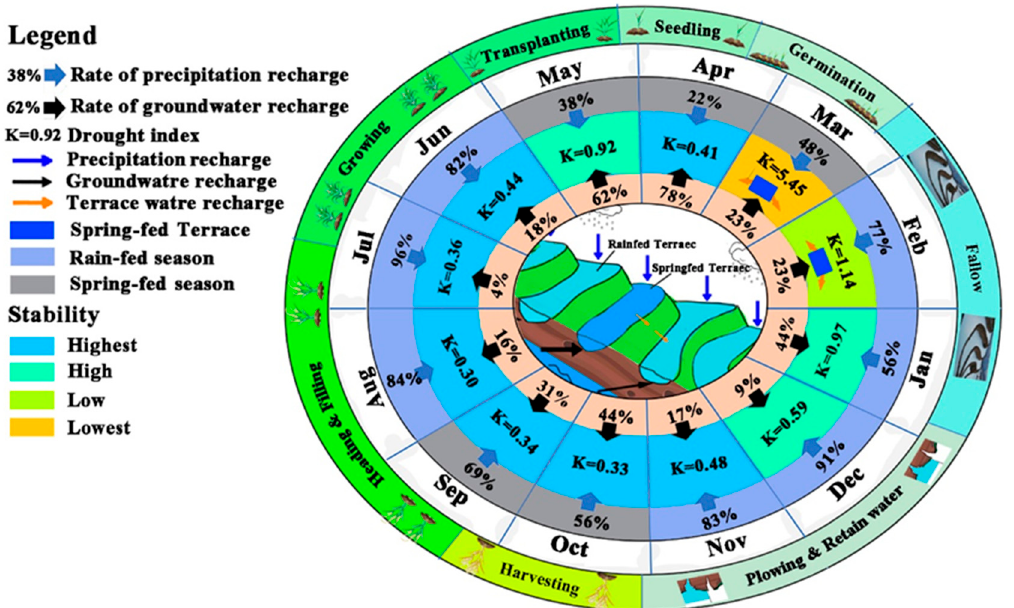
Figure 10. Temporal and spatial stability mechanism of terrace water sources: when K < 0.05, stability is highest; 0.5 ≤ K ≤ 1, stability is high; 1 < K ≤ 1.25, stability is low; and K > 1.25, stability is lowest.